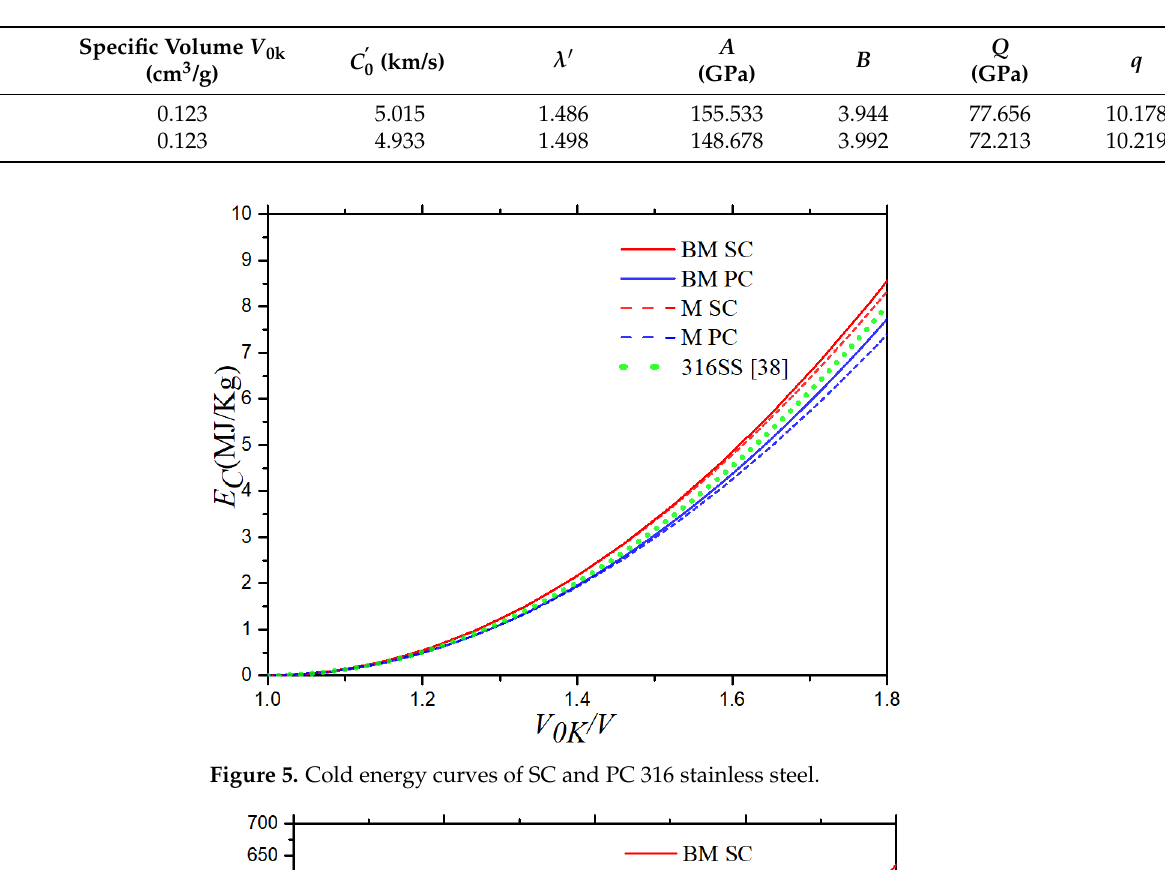
Table 3. Material constants of 316 stainless steel.